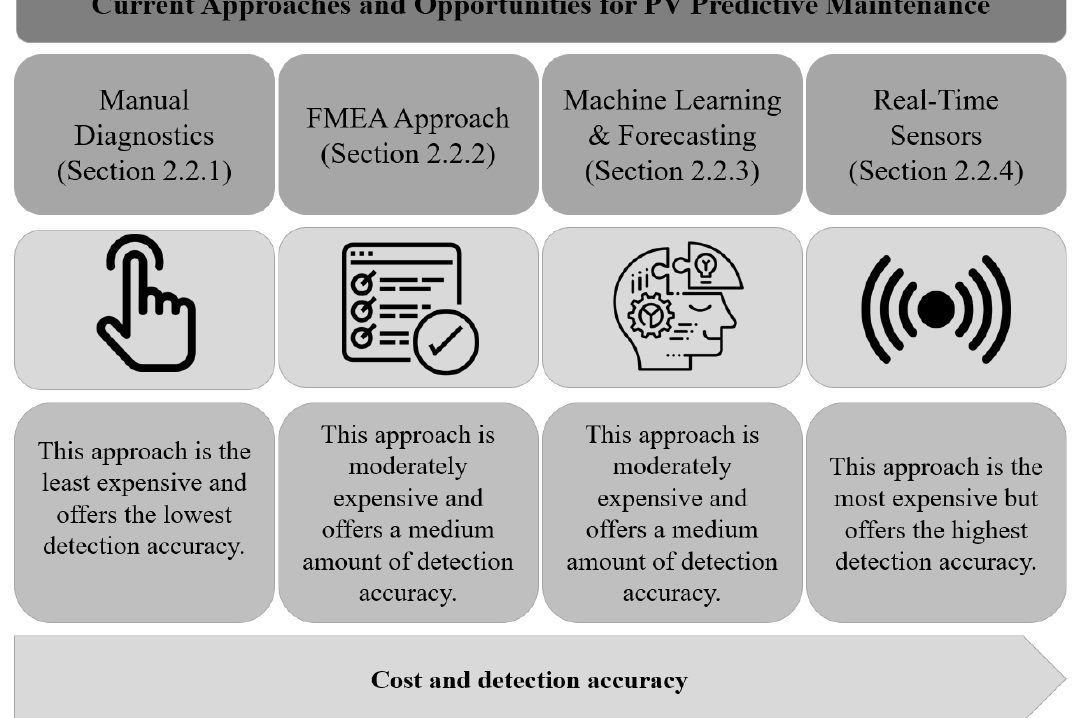
Figure 1. Summary of current approaches for PV predictive maintenance.